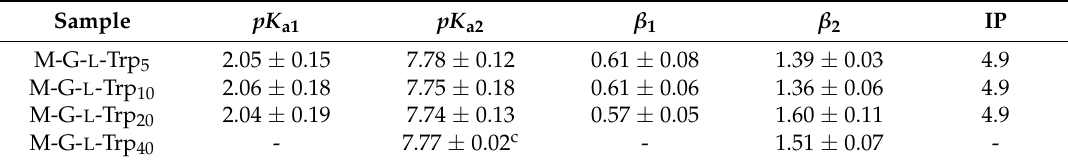
Table 3. pK a and β values of M-G- L -Trp copolymers in the α range 0.2–0.8 ( β 1 ) and 0.1 − 0.9 ( β 2 ).